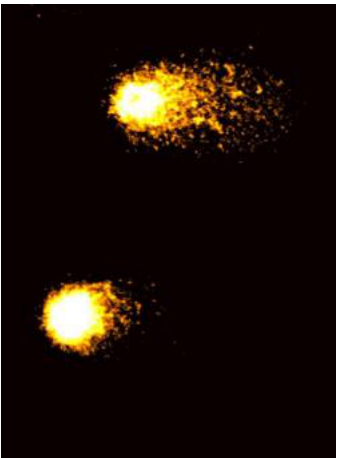
Figure 1. Comet test: image of damaged and undamaged salivary leukocytes observed through fluorescence microscopy.